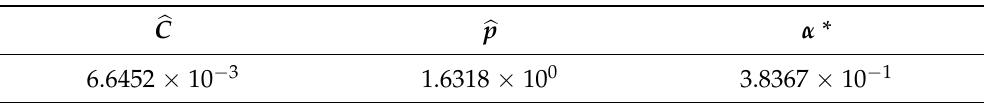
Table 5. Optimal estimates of the modified Johnson–Cook constitutive parameters (cid:98) C and (cid:98) p along with the optimal regularization parameter α